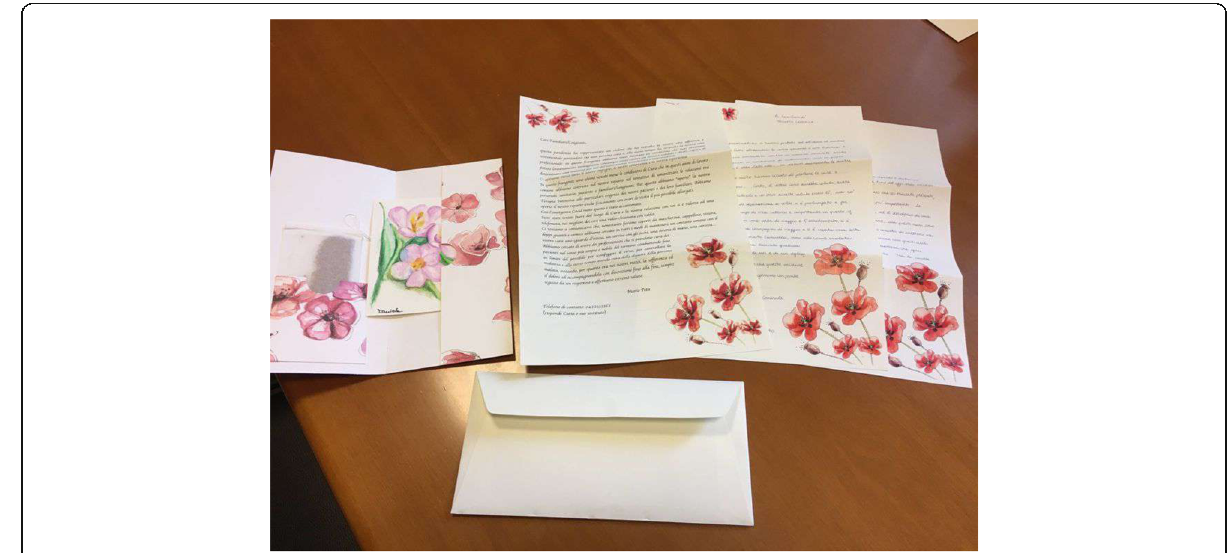
Fig. 1 An example of a letter sended to the